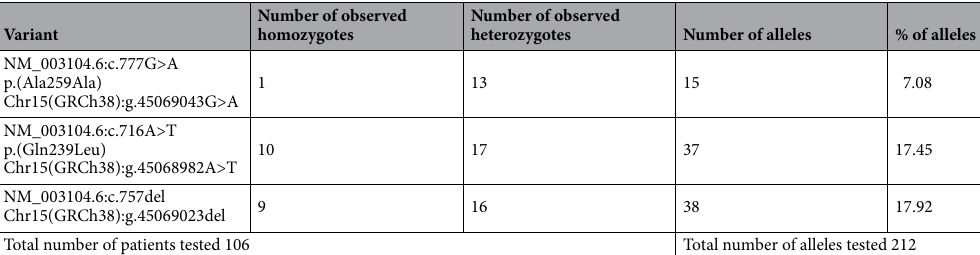
Table 4. Frequencies of SNPs in exon 7 of the SORD gene in our samples.